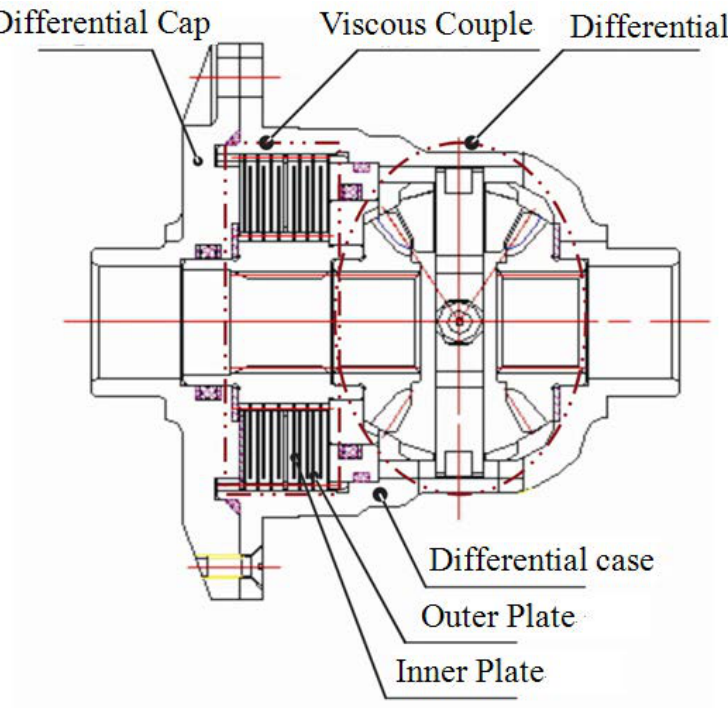
Figure 8. Prototype of the